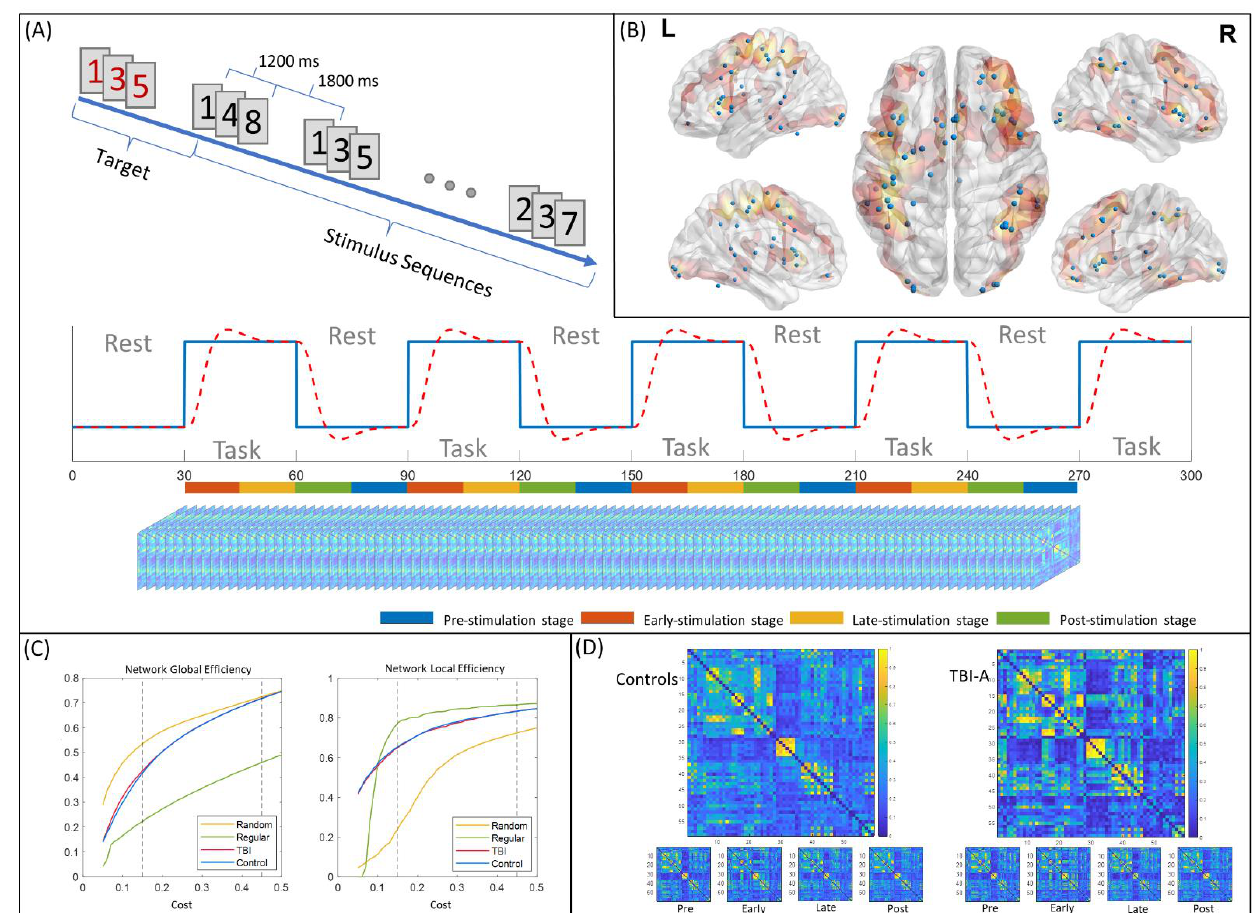
Figure 1. Functional network construction steps. ( A ) Block design and sub-stage definitions. ( B ) Selected nodes for functional network construction; ( C ) The network global and local efficiency curves of TBI-A and controls over the cost range of 0.05 to 0.5; ( D ) The group connectivity matrices of controls and TBI-A. L: left hemisphere; R: right hemisphere; TBI-A: children with severe post-traumatic brain injury attention deficits; Pre: pre-stimulation stage; Early: early stimulation stage; Late: late-stimulation stage; Post: post-stimulation stage.